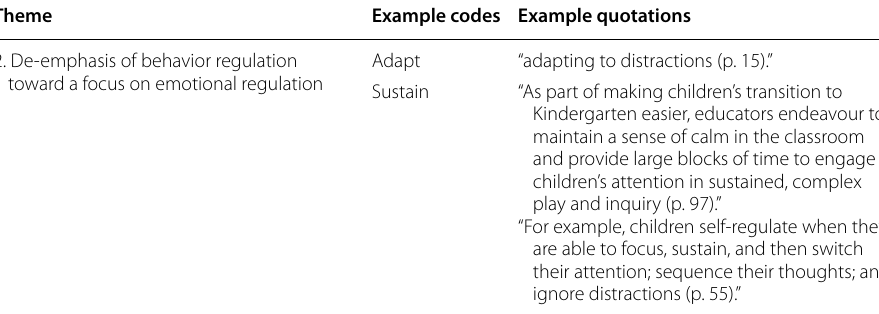
Table 3 Overview of Theme 2, example codes, and quotations